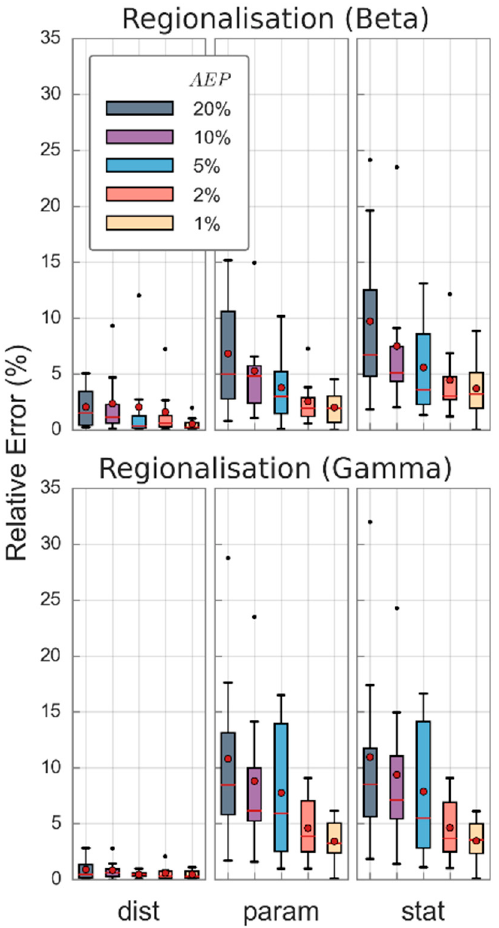
Figure 7. Distribution of relative errors in design flood estimates for each flood quantile across the eight study catchments using various methods to regionalize probability-distributed initial losses (parametric models). (Here, Beta and Gamma distributions are used to regionalize initial loss distri- bution).